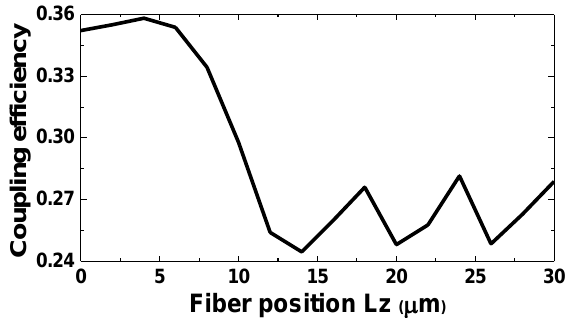
Figure 4. Coupling efficiency as a function of Lz .